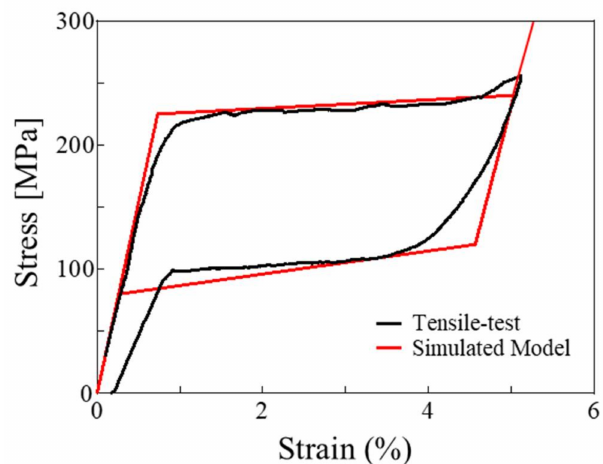
Figure 8. The stress–strain curve of heat-treated Ti-Ni SMA element with flat tape shape obtained by tensile test at 333 K and of the material model input into the